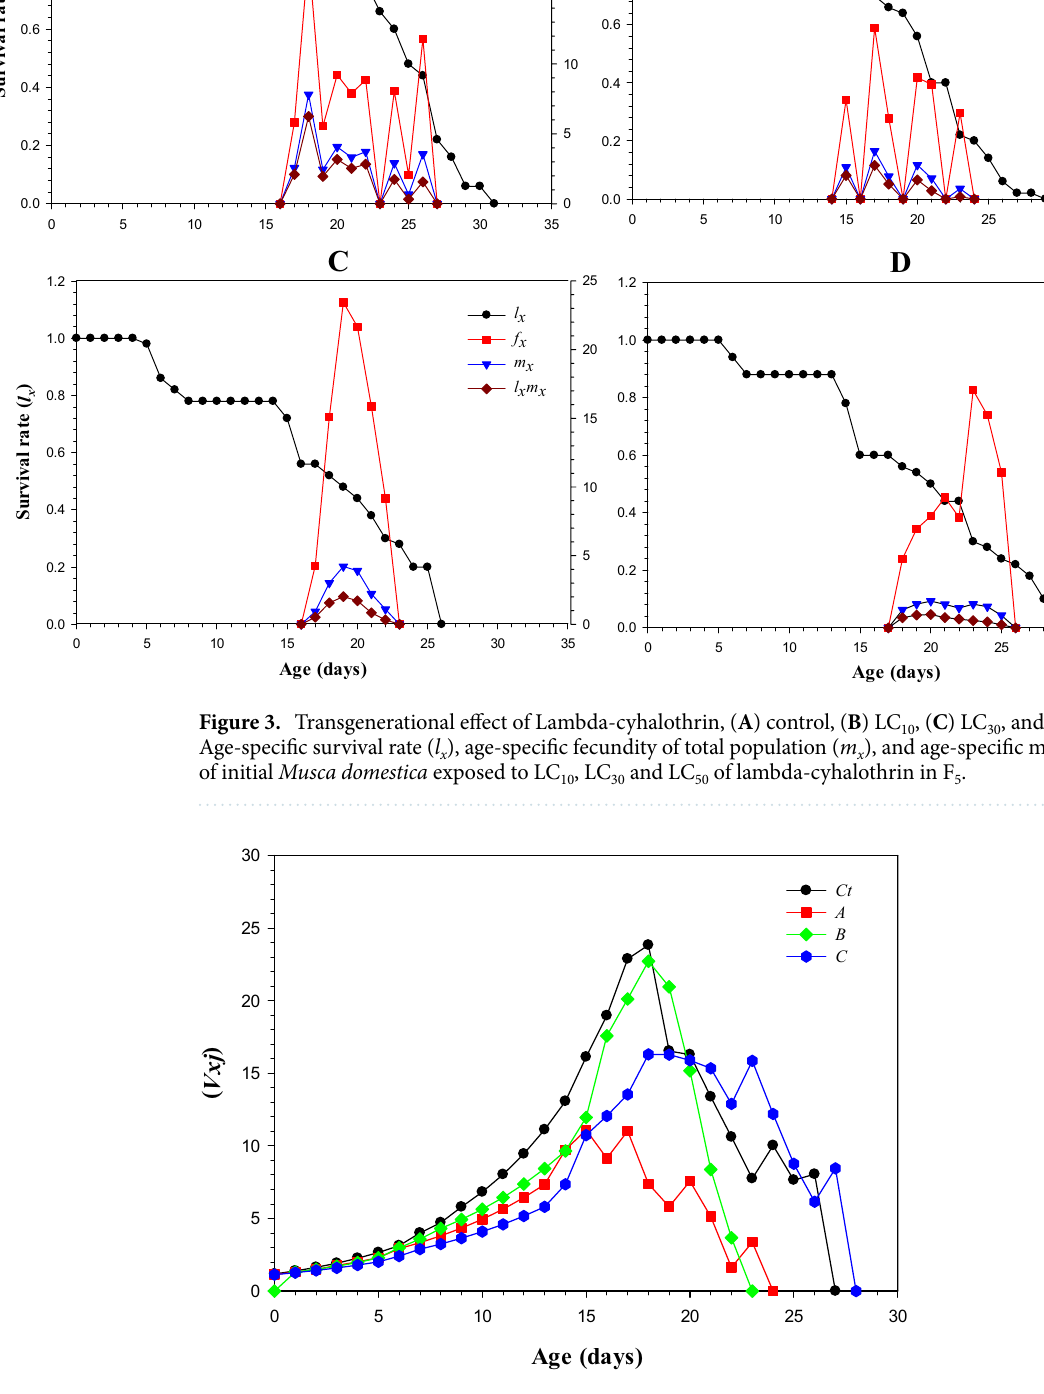
Figure 4. Transgenerational effect of lambda-cyhalothrin on reproductive value ( V xj ) on Musca domestica *Ct) control, A) LC 10 , B) LC 30 , and C) LC 50